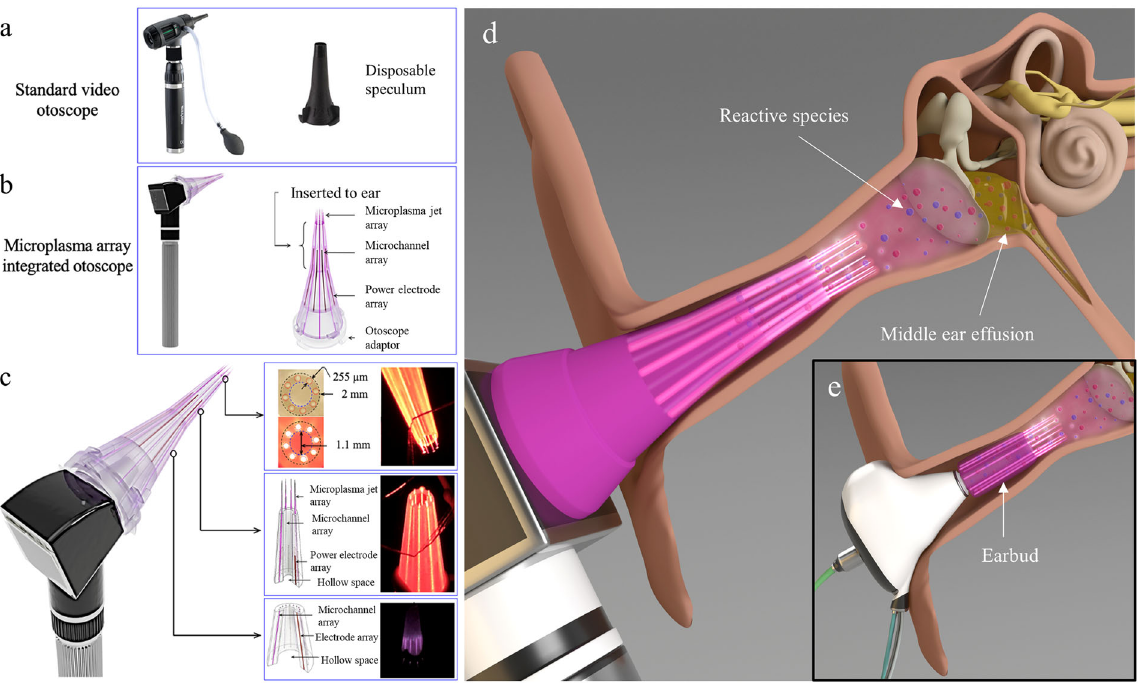
Fig. 7 Designs of microplasma delivery platforms for the ear. a A standard otoscope and its disposable speculum. b Representative view of the otoscope speculum integrated with microplasma jet array. c Diagrams and photos of the speculum head with neon microplasma jets produced in the microchannels. The panels show the end-on, cross-sectional view of the speculum head, and the conical microchannel array that can alternatively be used for gas delivery and power electrodes. d Illustration of the microplasma-integrated otoscope delivery platform in the ear. e Illustration of an earbud-based microplasma delivery platform in the ear for longer treatment durations. The hollow center space for both designs in d , e allows for visual access and